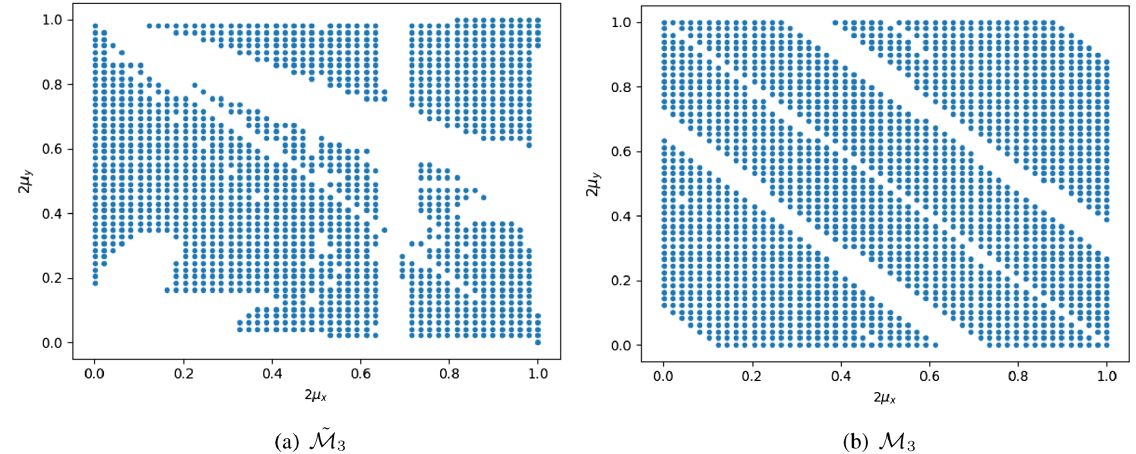
FIG. 8. Stability diagrams of third-order maps, x 0 ¼ y 0 ¼ 0 . 5